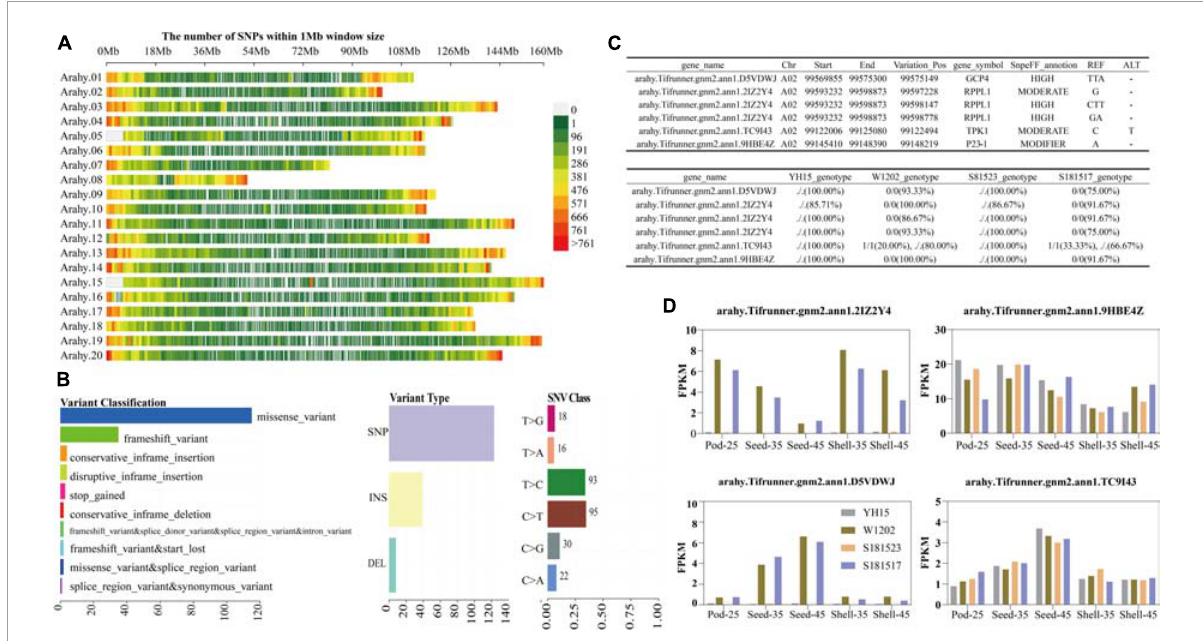
FIGURE9 Variant loci associated with pod developmental traits were mined. (A) Genetic mapping of SNPs within 1Mb window size obtained by comparing them to the cultivated peanut reference genome. Chr01-chr20 corresponds to Arahy.01-Arahy.20. (B) Cohort summary plot displaying the distribution of variants according to variant classification, type, and SNV class. (C) Detailed information on the genetic variation of the four genes screened on the reported 92751772–99808878 bp QTL interval of the A02 chromosome.“./.” means identical to ALT genotype at the Variation_Pos and “0/0” means identical to REF genotype at the Variation_Pos. (D) FPKM values of arahy.D5VDWJ , arahy.2IZ2Y4 , arahy.TC9I43, and arahy.9HBE4Z at different developmental